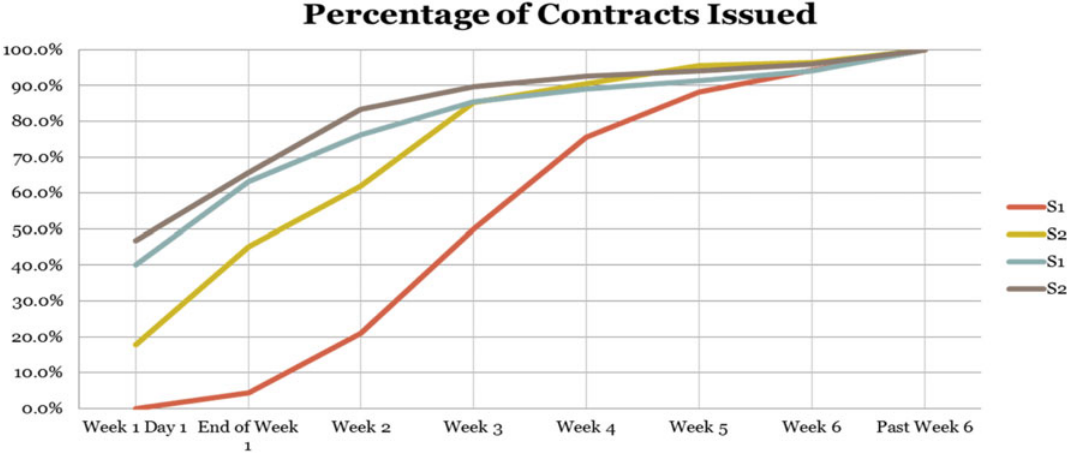
Figure 2. (Colour online) ITAS contracts issued (graph courtesy of Dr Katherine